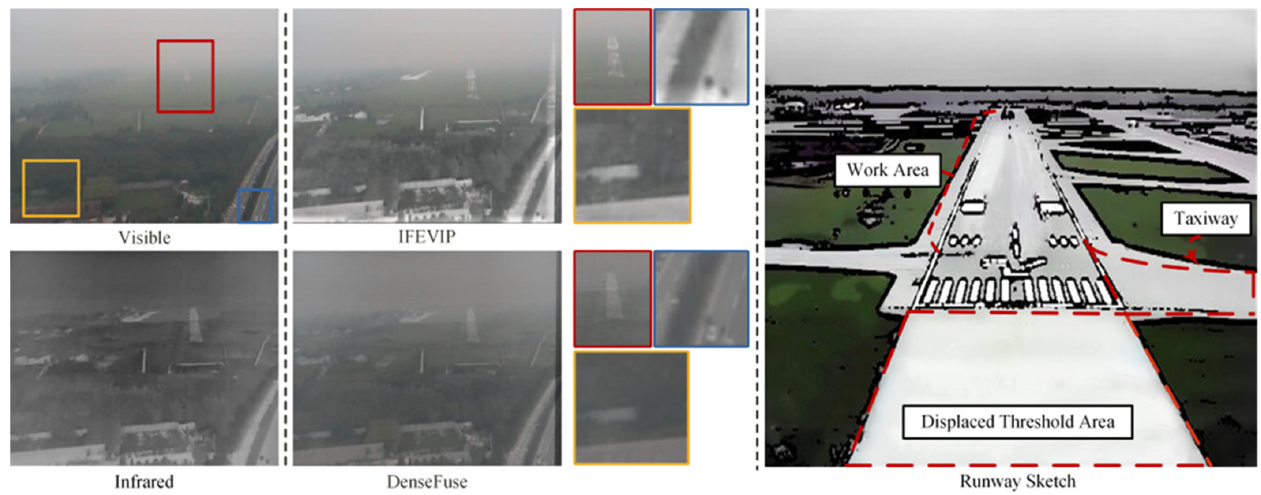
Figure 2. Experimental results of existing fast algorithms and landing composition diagram.